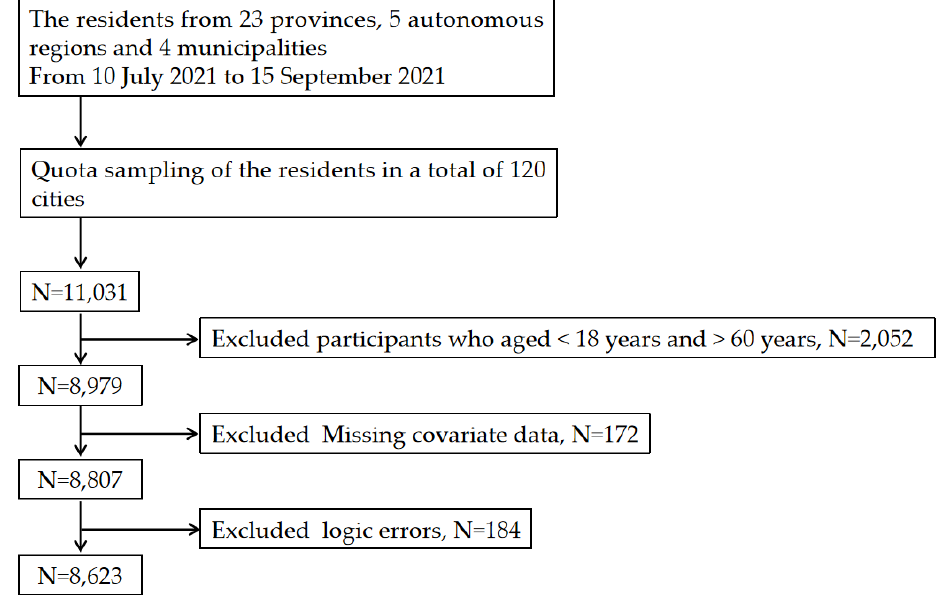
Figure 2. Flowchart of participant enrollment.